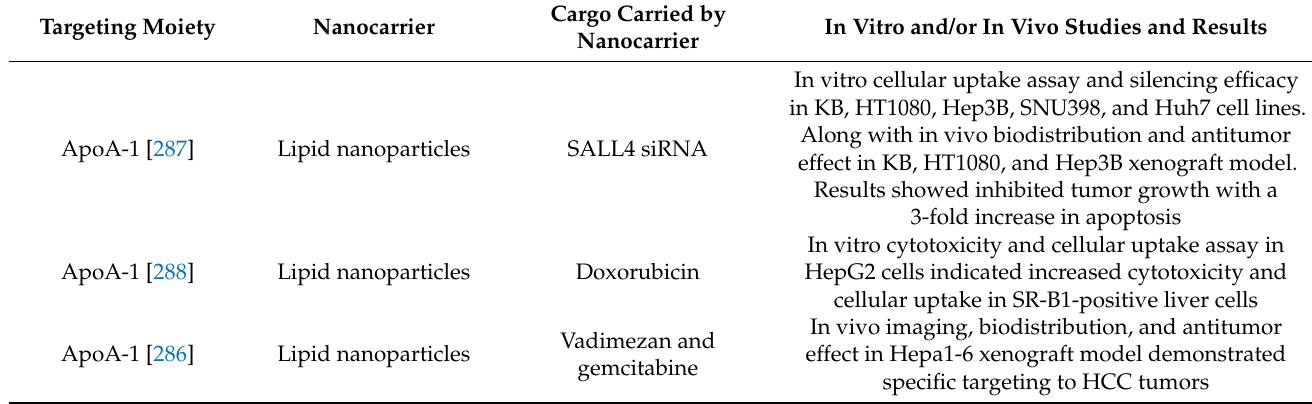
Table 6. Brief summary showing the different nanoformulations designed using SR-B1 receptor as a